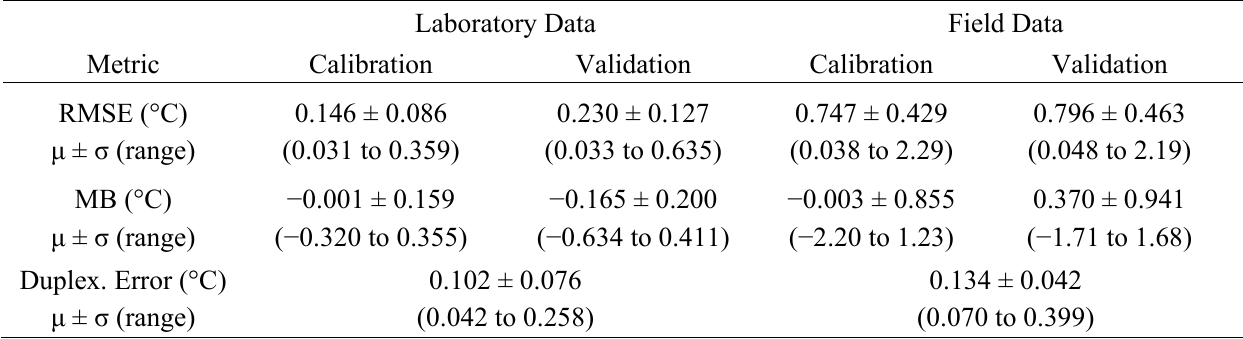
Table 4. Calibration metrics for static calibration.